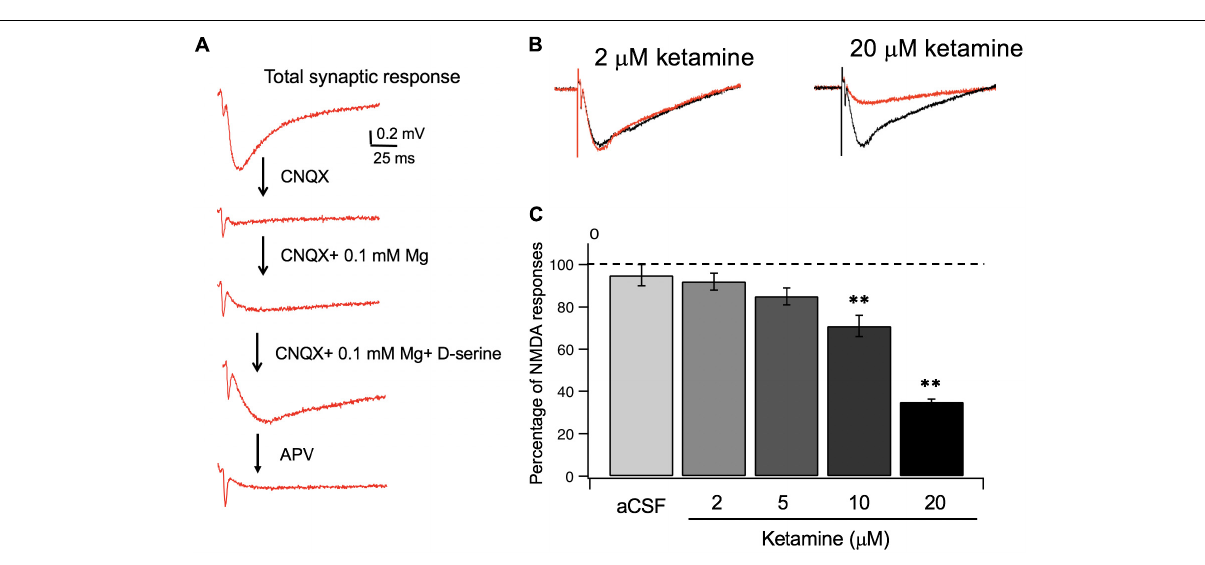
FIGURE 3 | Ketamine’s concentration-dependent effects on synaptic NMDA responses. (A) Pharmacological isolation of synaptic NMDA responses in hippocampal slices. Field EPSPs (fEPSP) recorded in normal aCSF are primarily mediated by AMPA receptors (a) , which were completely blocked by CNQX, an AMPA receptor antagonist (b) . Wash-in of aCSF containing 0.1 mM Mg2 + unblocks NMDAR, resulting in a slow and small voltage changes in postsynaptic membranes (c) . Lastly, addition of D-serine, the endogenous NMDAR agonist, resulted in an enhanced synaptic NMDA response (d) , which was completely blocked by APV, an